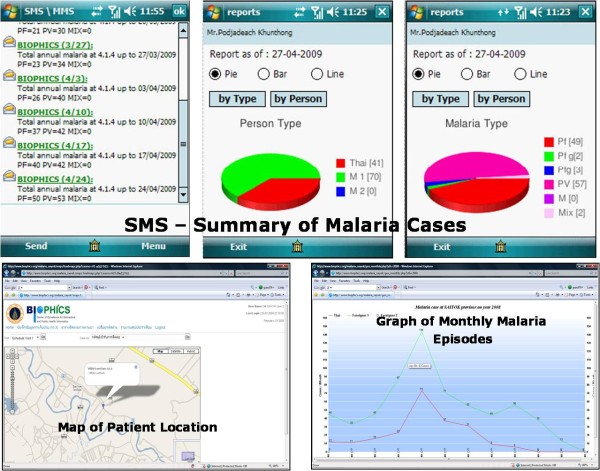
Screen shots of summary reports & graphs on mobile phone/site workstation.